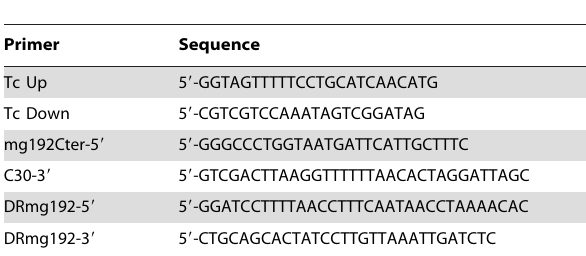
Table 3. Primers used in this